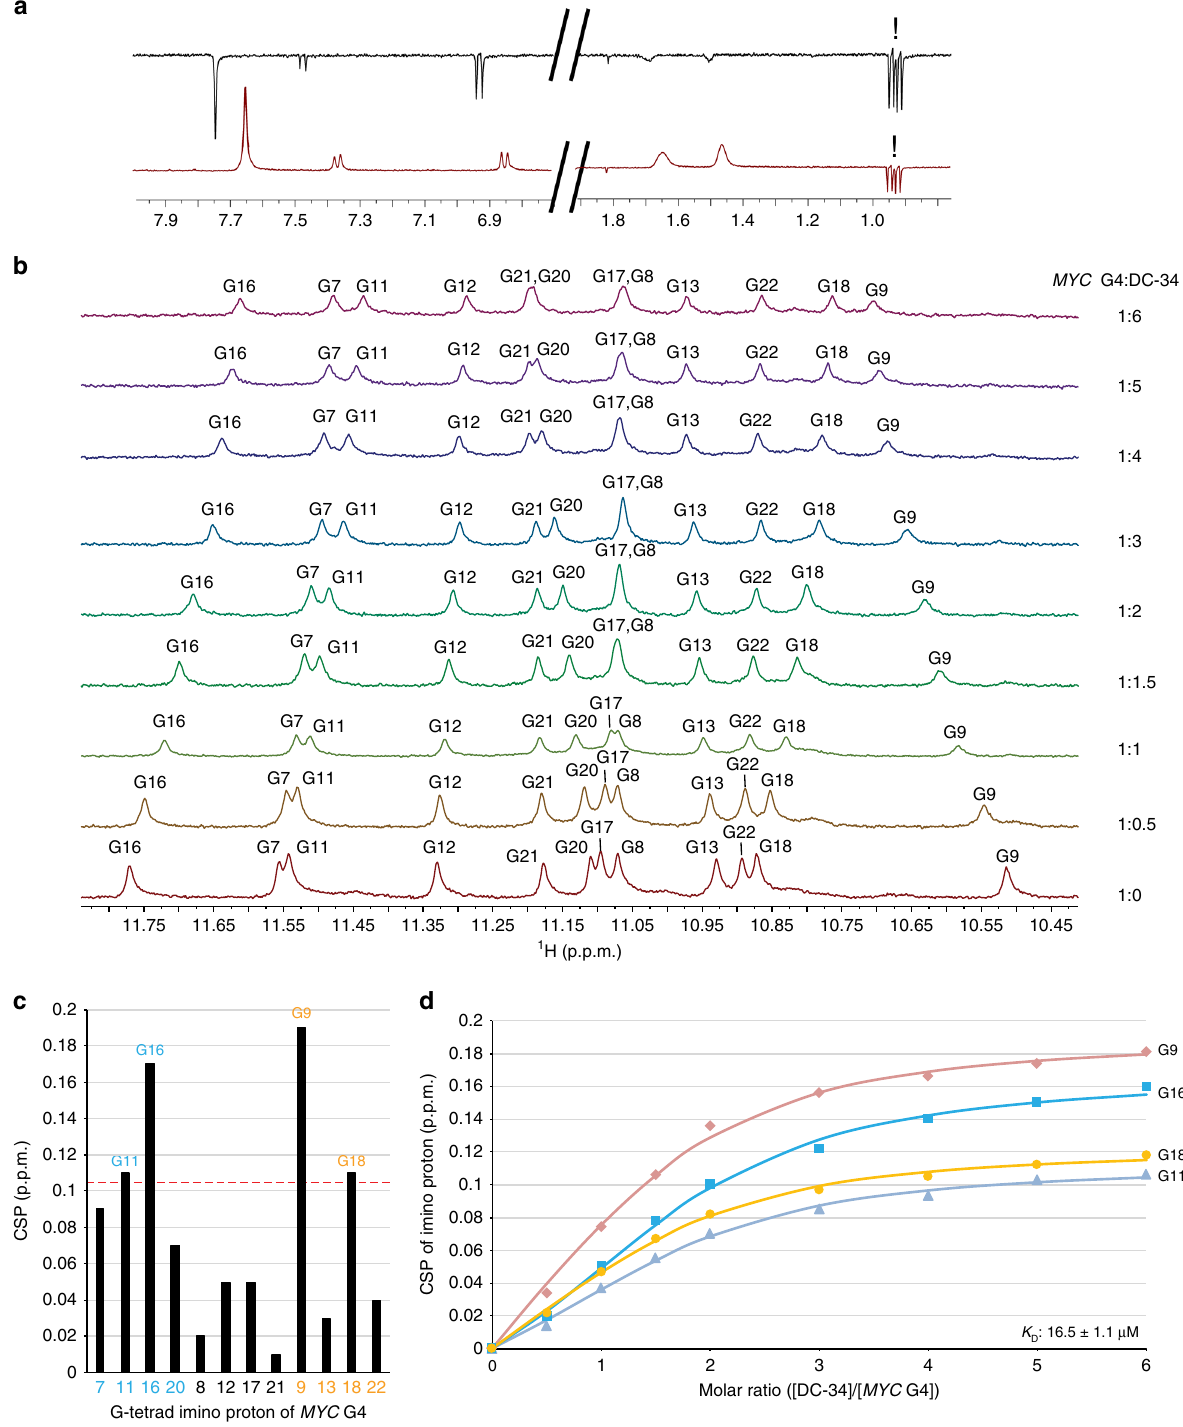
Fig. 5 Shifting of imino protons during a titration experiment indicates DC-34 binding to each end of MYC G4. a WaterLOGSY NMR spectra of DC-34 and N-methyl- L -valine (non-binding control, peaks indicated with !) in the absence (top) and presence (bottom) of MYC G4. b Expanded 1D 1 H NMR spectra illustrating the imino region during titration of DC-34 into MYC G4. Molar ratios of MYC G4:DC-34 are as indicated at 1:0, 1:0.5, 1:1, 1:1.5, 1:2, 1:3, 1:4, 1:5, and 1:6. The G-tetrad imino protons are labeled in each spectrum. c Plot of chemical shift perturbation (CSP) comparing MYC G4 G-tetrad imino protons alone and with sixfold molar excess DC-34. The red dashed line indicates one standard deviation above the average value. d CSP values for G9 (red), G11 (purple), G16 (blue), and G18 (orange) H1 plotted against molar ratio of DC-34 to MYC G4. An overall K D value of 16.5 ± 1.1 µ M was obtained by fi tting the data to a non-cooperative binding mode with the software package Bind fi t